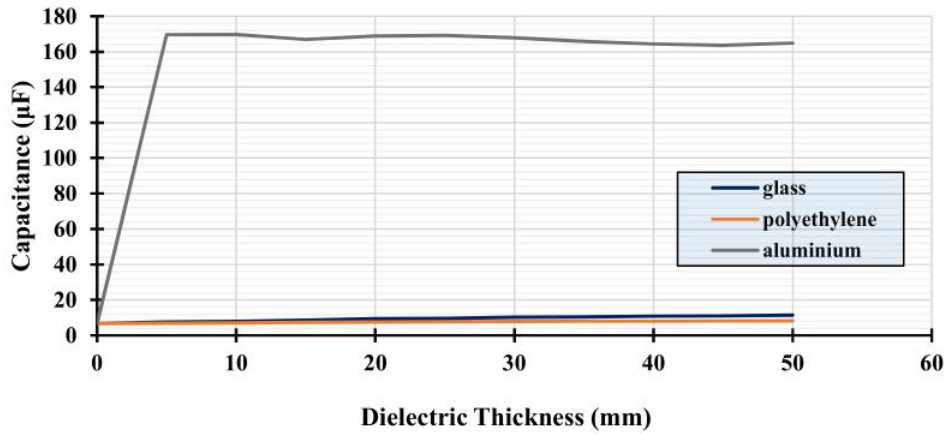
Figure 16. Secondary capacitance.